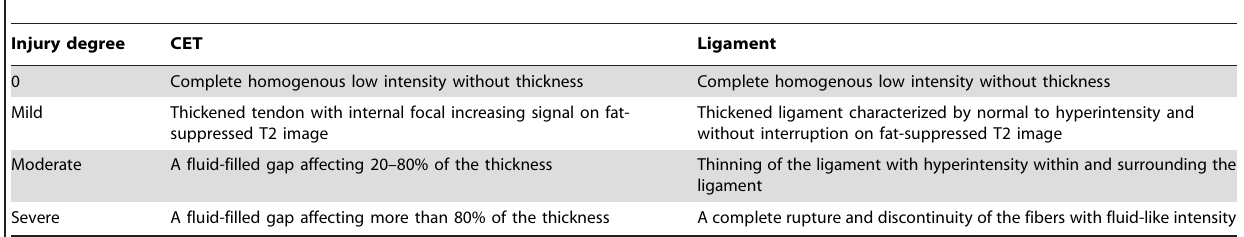
Table 2. The classification of the CET and ligament injury.